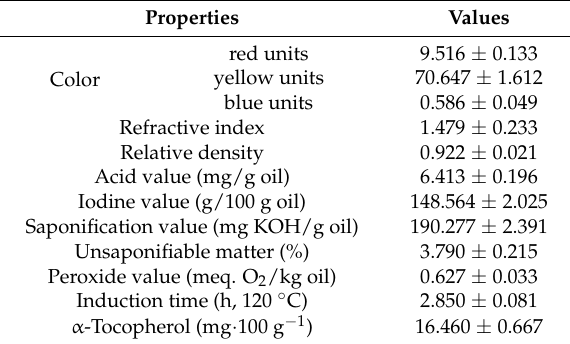
Table 3. Physicochemical characteristics of fenugreek seed oil.